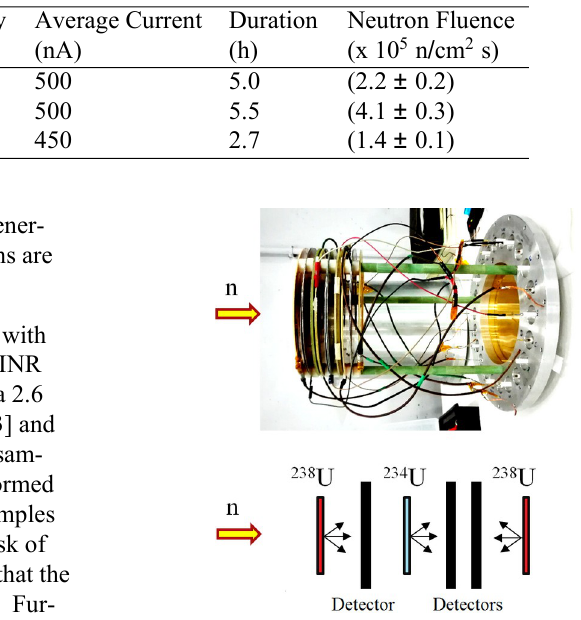
Figure 2. Photograph of the Al chamber interior in which the pairs of sample-detector were placed (top), along with the schematic representation of the target assembly during the irra- diation